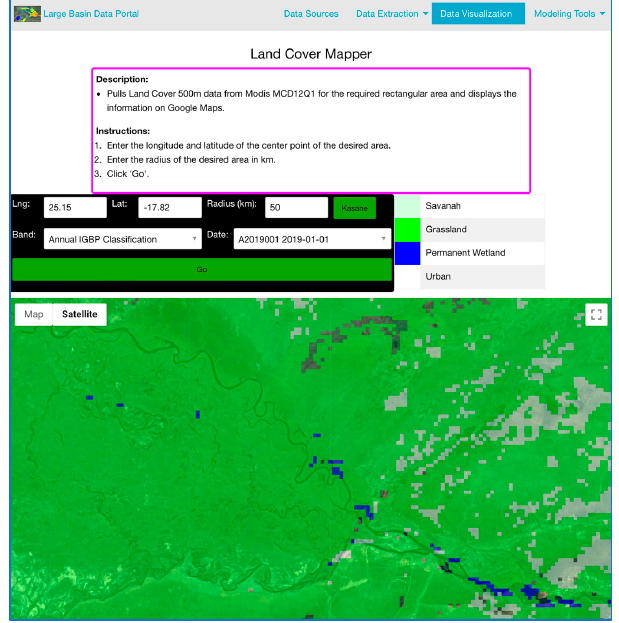
Figure 9. Screenshot of the Large Basin Data Portal land cover mapper with input parameters and the displayed map of the eastern section of the Chobe–Zambezi flood plains, Africa. The colored overlay represents different types of land cover type. Data are derived from the MODIS MCD12Q1 dataset for the year 2019, and are based on the Annual IGBP classification imbedded in the dataset.